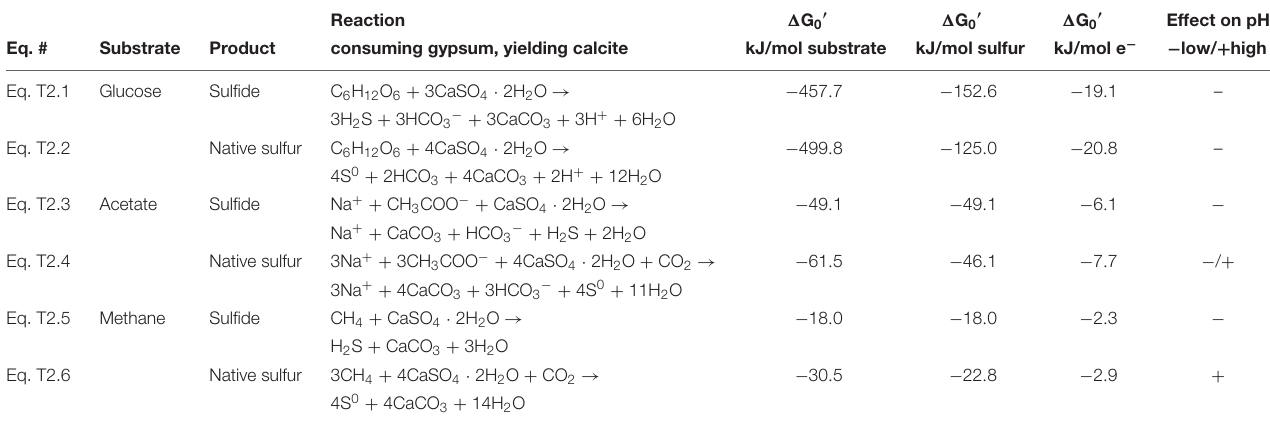
TABLE 2 | Gibbs free energy yield for oxidation of hydrocarbons coupled to sulfate reduction.